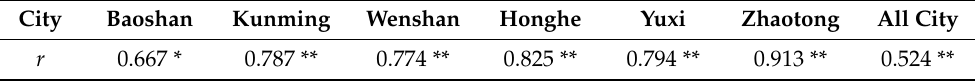
Table 4. Pearson correlation coefficient ( r ) between the monthly emission factor of PM 2.5 in soil fugitive dust and the monthly PM 2.5 concentration of the atmospheric environment in six cities in 2018. City Kunming Yuxi All City r 0.667 * 0.787 ** 0.774 ** 0.825 ** 0.794 ** 0.913 ** 0.524 **